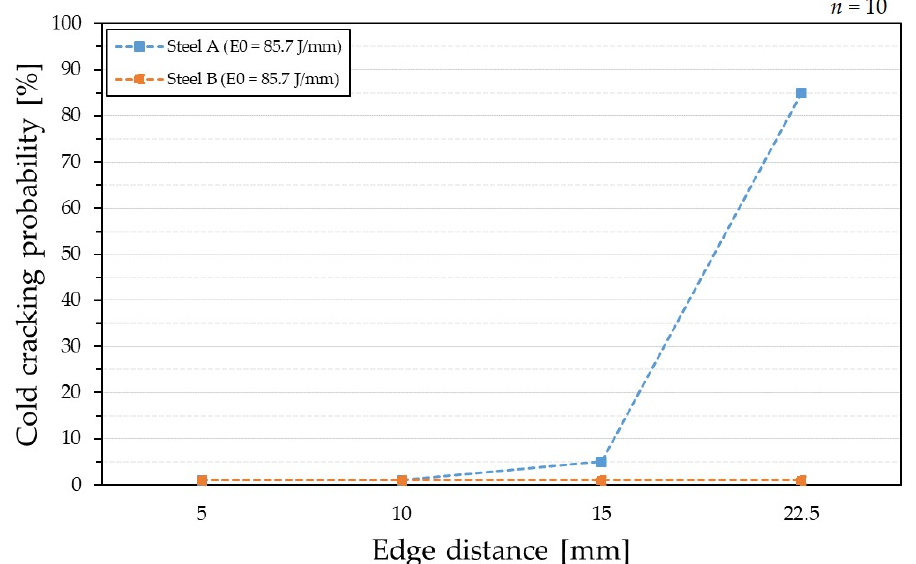
Figure 7. Critical edge distances of the weld seams to cold cracking for steels A and B.